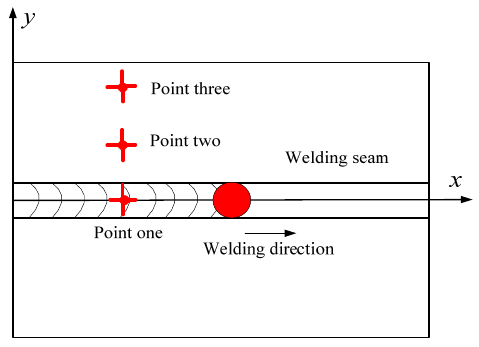
Figure 10. Temperature measuring point distribution. Appl. Sci. 2017 , 7 , 69